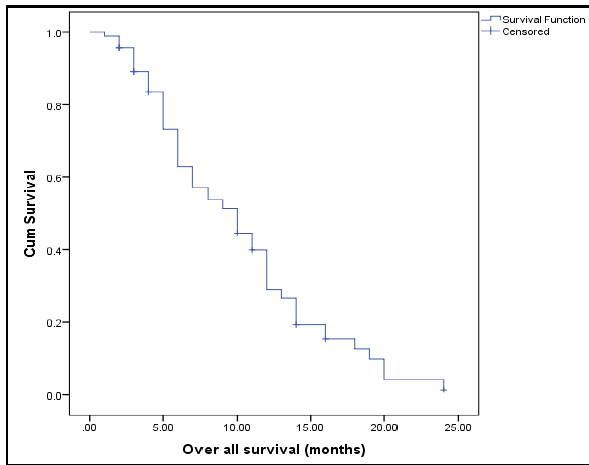
Figure 2: Kaplan-Meier overall survival curve for all patients Tables 2 and 3 illustrate PFS and OS according to the studied variables. Progression-free survival differed significantly temozolomide therapy and steroidal dependency (p = 0.012, 0.001, 0.025, 0.038 and < 0.001; respectively) (figure 3). Overall survival differed significantly according to age, baseline ECOG performance status, type of surgery, steroidal dependency and adjuvant temozolomide therapy (p = 0.002, 0.032, 0.048, <0.001 and 0.024; respectively) (figure 4).